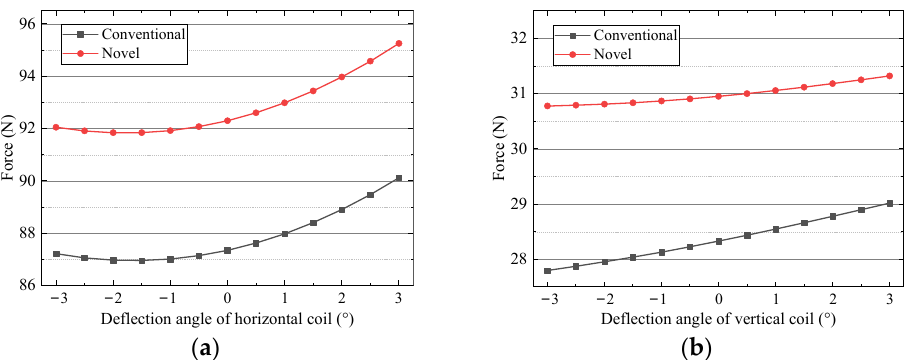
Figure 18. Driving force versus deflection around z -axial: ( a ) horizontal coil ( b ) vertical coil.